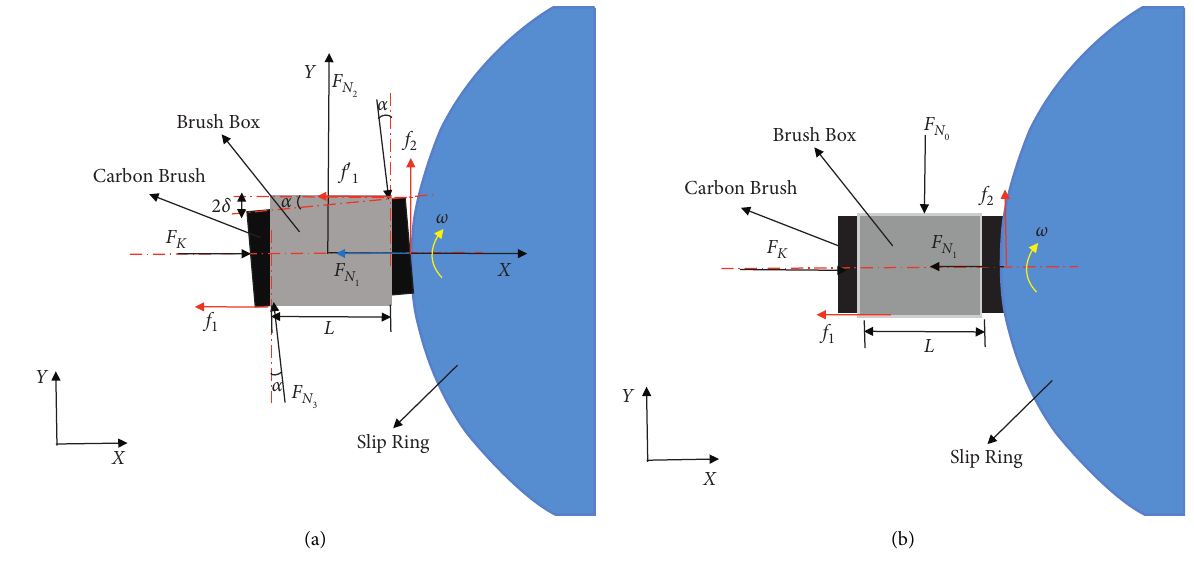
Figure 2: Force diagram of the carbon brush in the contact